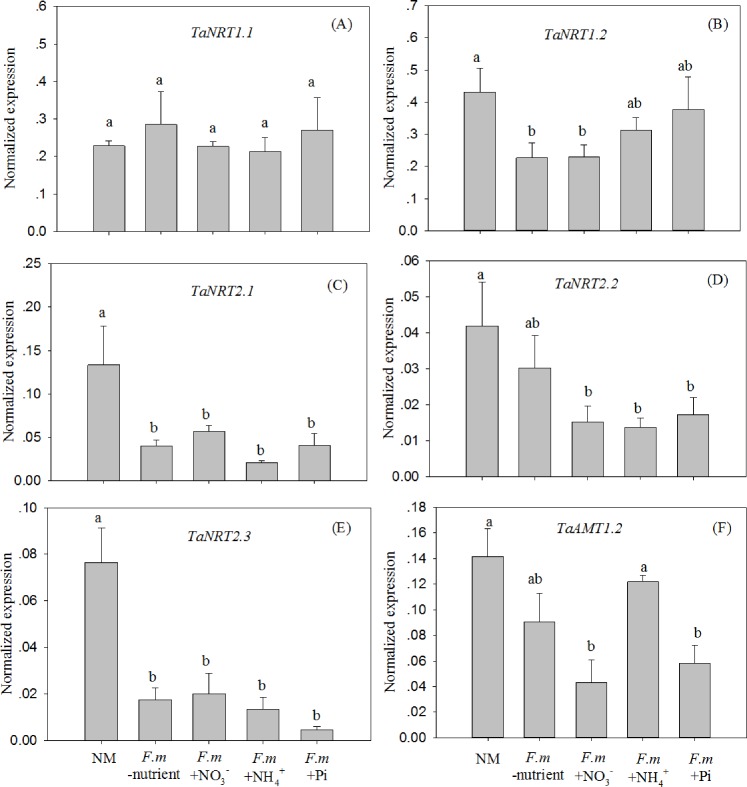
Relative expression of five nitrate transporter genes (A–E) and an ammonium transporter gene (F) in experiment I. NM, non-mycorrhizal control; F.m-nutrient, wheat roots in RHC inoculated with AM fungus Funneliformis mosseae, but no nutrients were added to HC; F.m +NO3-, +NH4+, and +Pi, wheat roots in RHC were inoculated with AM fungus F. mosseae, and 15NO3- (10 mM K15NO3), 15NH4+ (10 Mm (15NH4)2SO4), or Pi (1 mM KH2PO4) was added to HC, respectively. Values are means and standard errors (n = 4). Data with the same letter indicates no significant difference among treatments (P > 0.05).